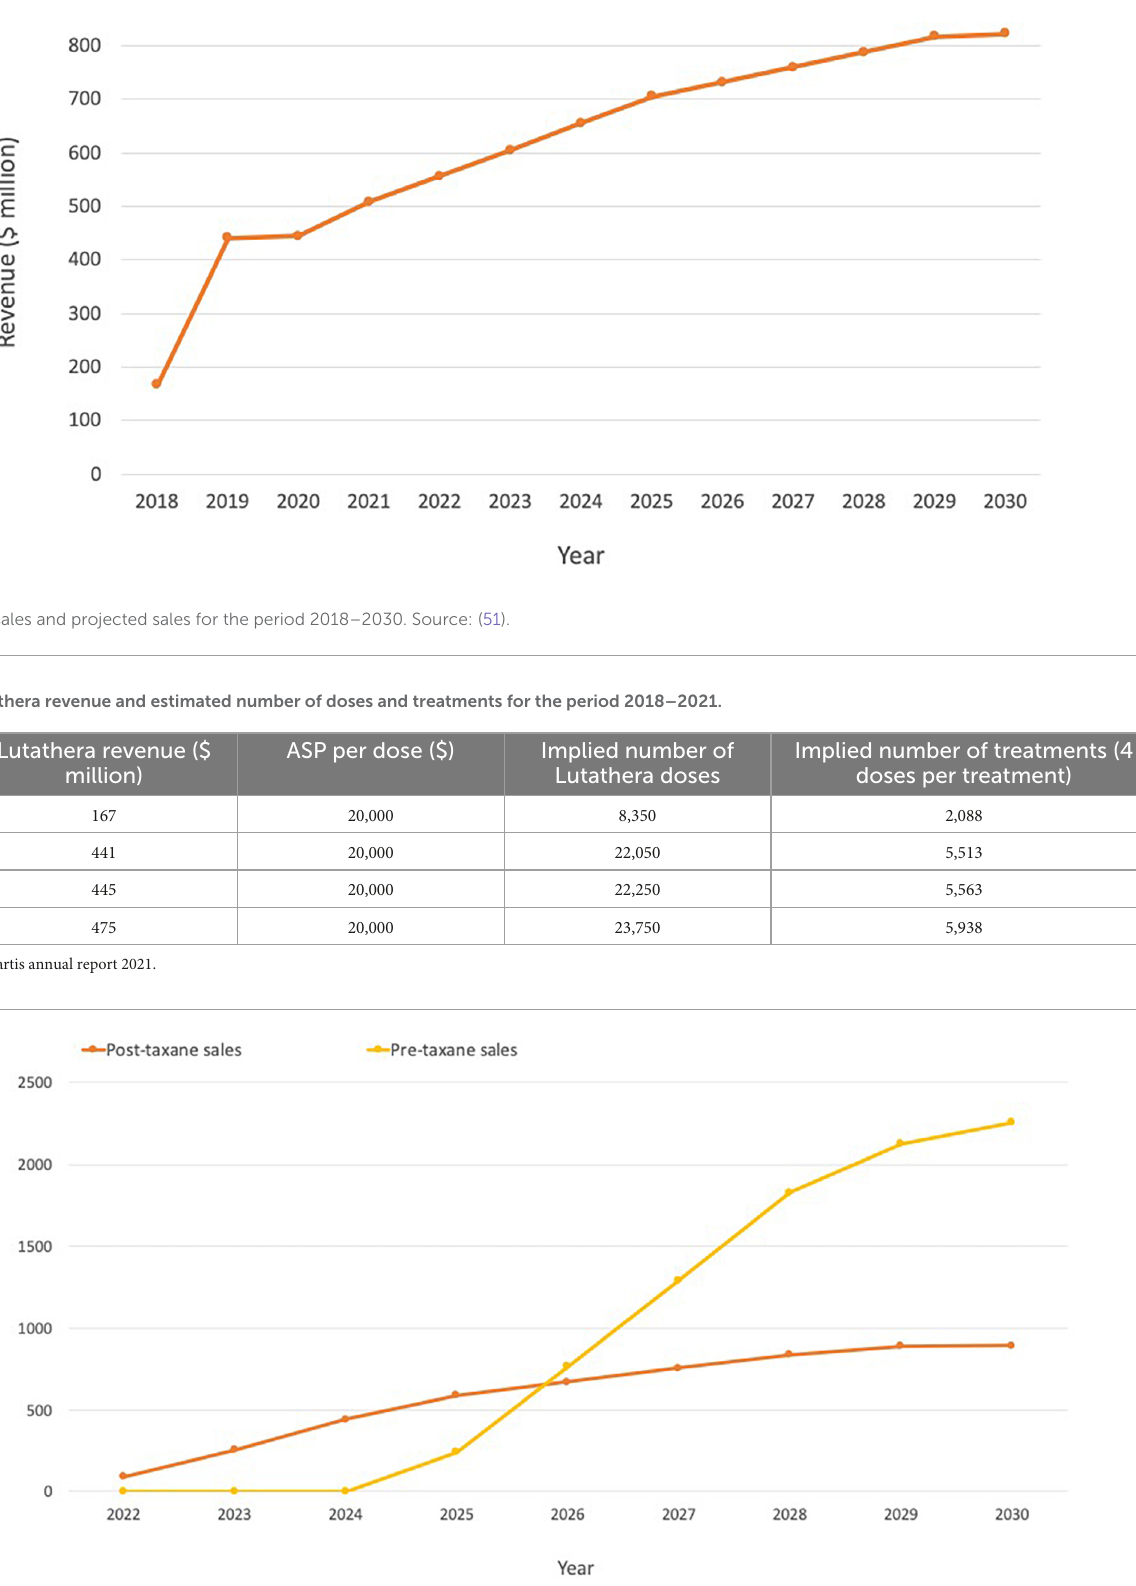
FIGURE5 Pluvicto sales projections. Projections include estimates for both pre- and post-taxane markets assuming ∼ 20% penetration in the US and ∼ 15% elsewhere. If Pluvicto is approved for the pre-taxane market, it is estimated that this would lead to an additional ∼ $2 billion on top of current projections for the post-taxane market. Based on estimates from